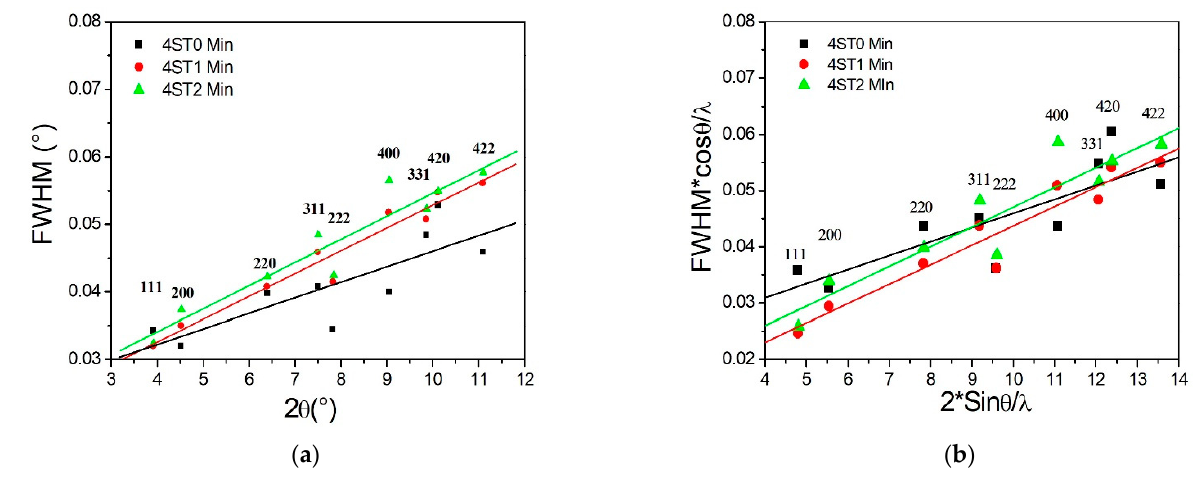
Figure 15. ( a ) FWHM as function of 2 θ in drawing direction for 4ST-Min. ( b ) Williamson–Hall plot for 4ST-Min.